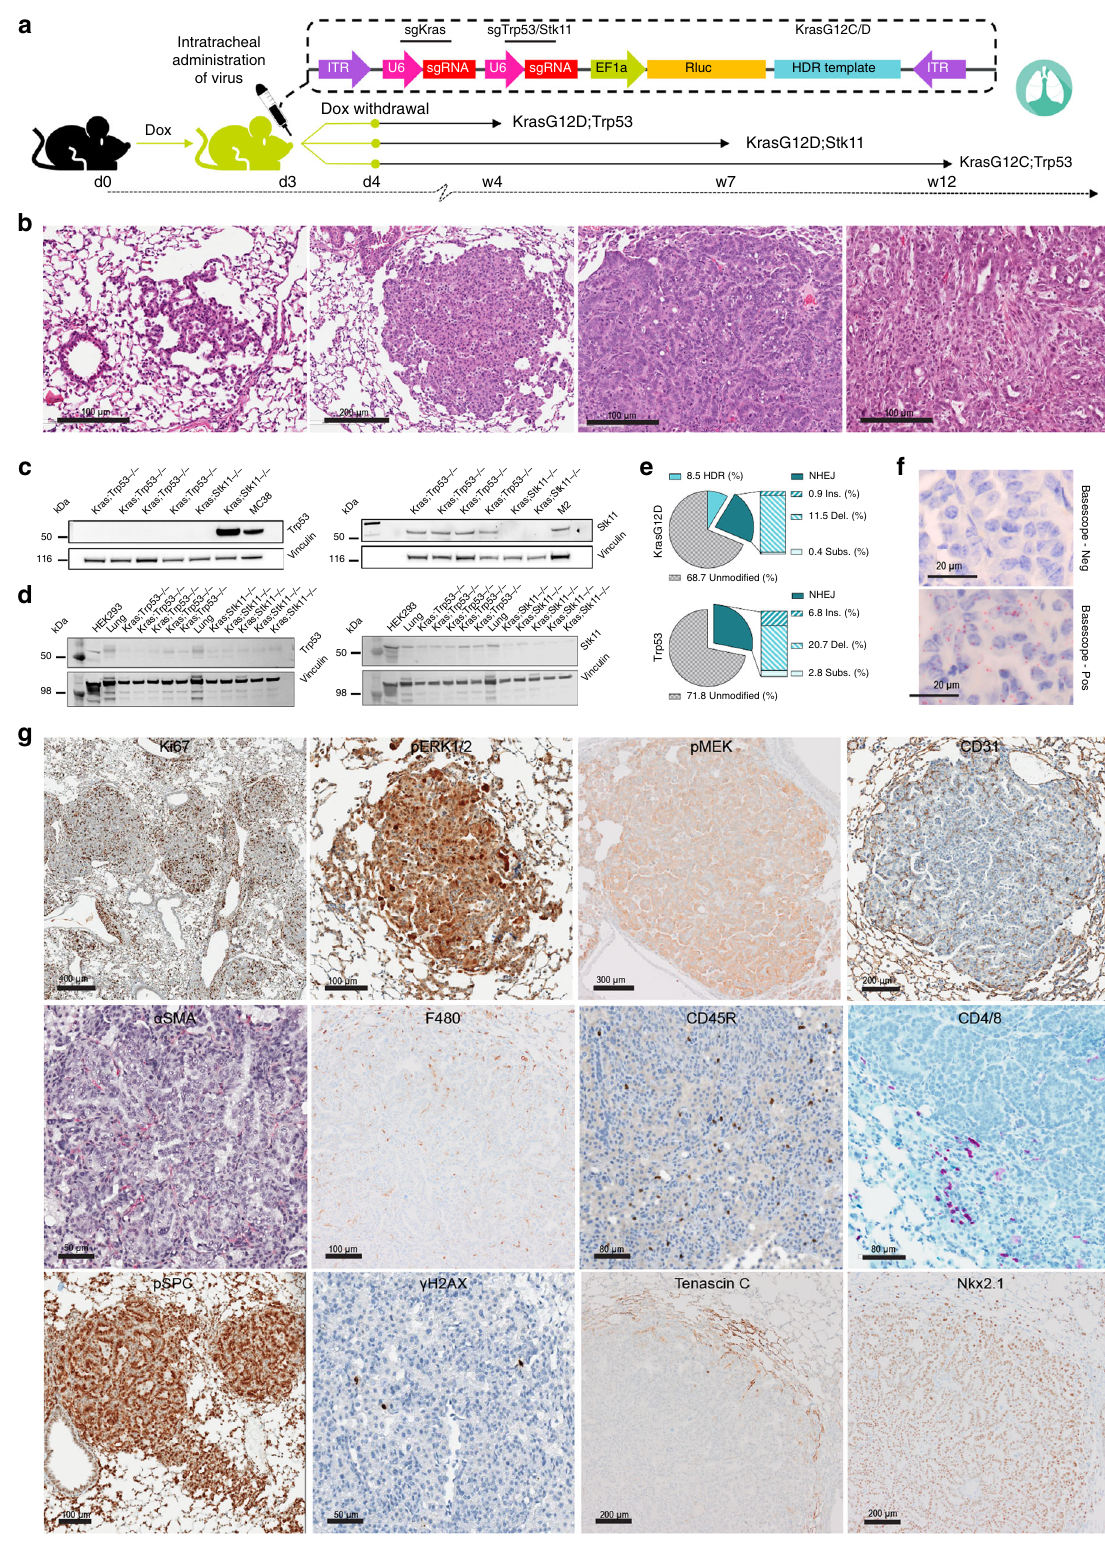
Docetaxel and the MEK inhibitor AZD6244 (Selumetinib) ( n = 6) for 2 weeks (Fig. 5a). At 4 weeks there was signi fi cant tumor burden as determined by histological assessment of satellite mice sacri fi ced prior to treatment (Fig. 5a, e). Combination therapy resulted in the stasis of tumor growth, measured by histology at termination, preventing the threefold increase observed